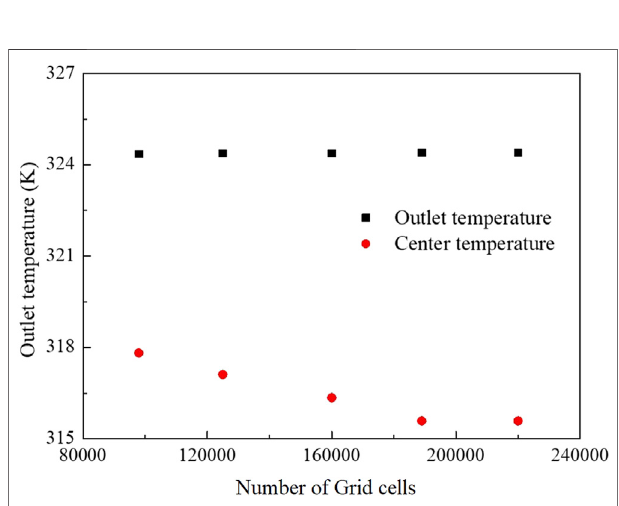
FIGURE 4 | Calculation results of cases with different number of grid